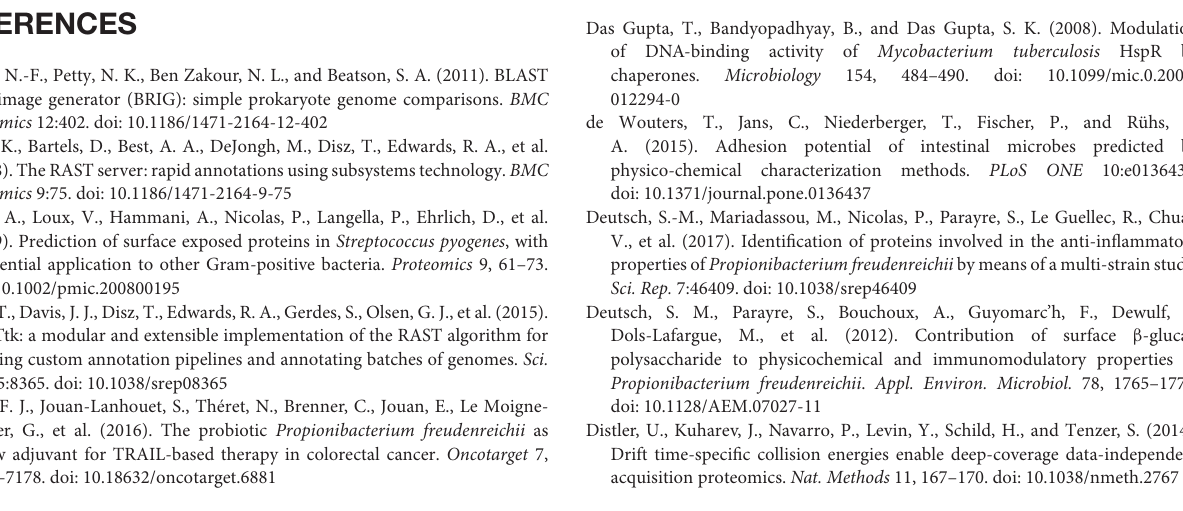
Figure S1 | Verification of assembly error by read mapping. The plasmid pUC: 1 slpB : Cm R was not inserted in the slpB gene during de novo genome assembly. The read mapping on the slpB gene shows misalignments upstream and downstream insertion site, confirming the assembly error. The read mapping was performed using in CLC Genomics Workbench 7.0. Figure S2 | Assembly curation and validation by read mapping. The manual insertion of plasmid pUC: 1 slpB : Cm R in the slpB gene was validated by read mapping. The correct read alignments upstream (A) and downstream (B) the plasmid validate the manual insertion. The read mapping was performed using in CLC Genomics Workbench 7.0. Table S1 | Total list of proteins identified in the core-proteome of CB 129 wild-type and CB129 1